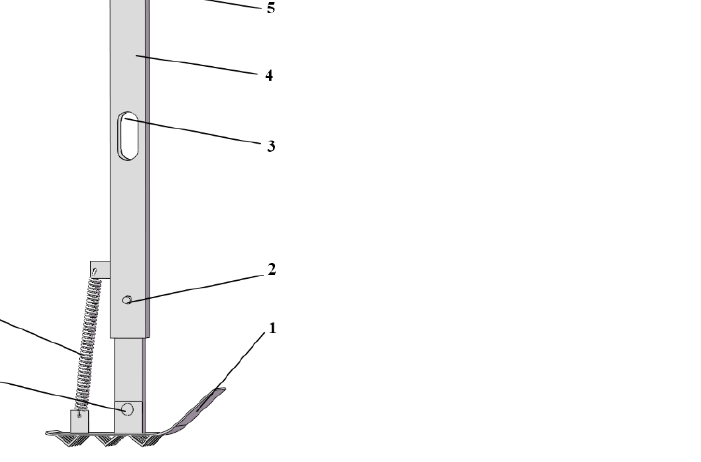
Figure 4. Structure drawing of weeding shovel. 1. Weeding board 2. Connection hole 3. Adjustment